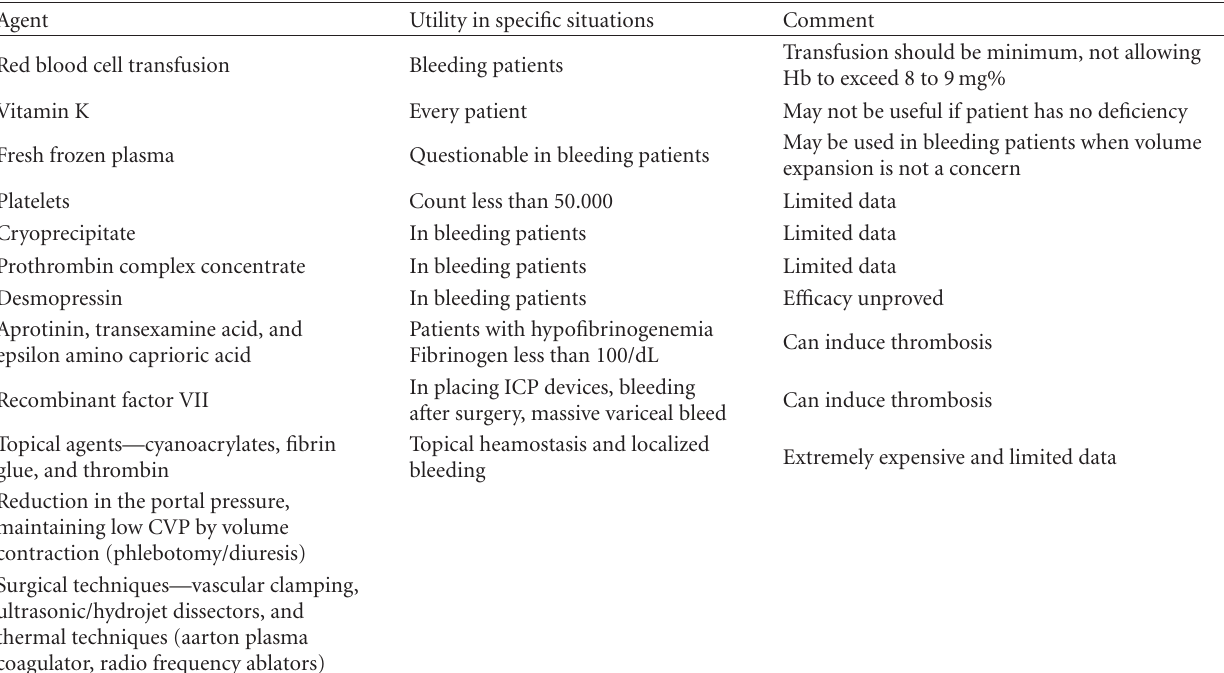
Table 1: Therapeutic options in coagulopathy in decompensated liver